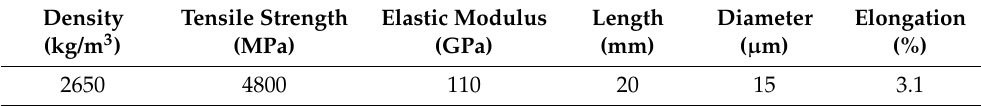
Table 5. The technical indexes of basalt